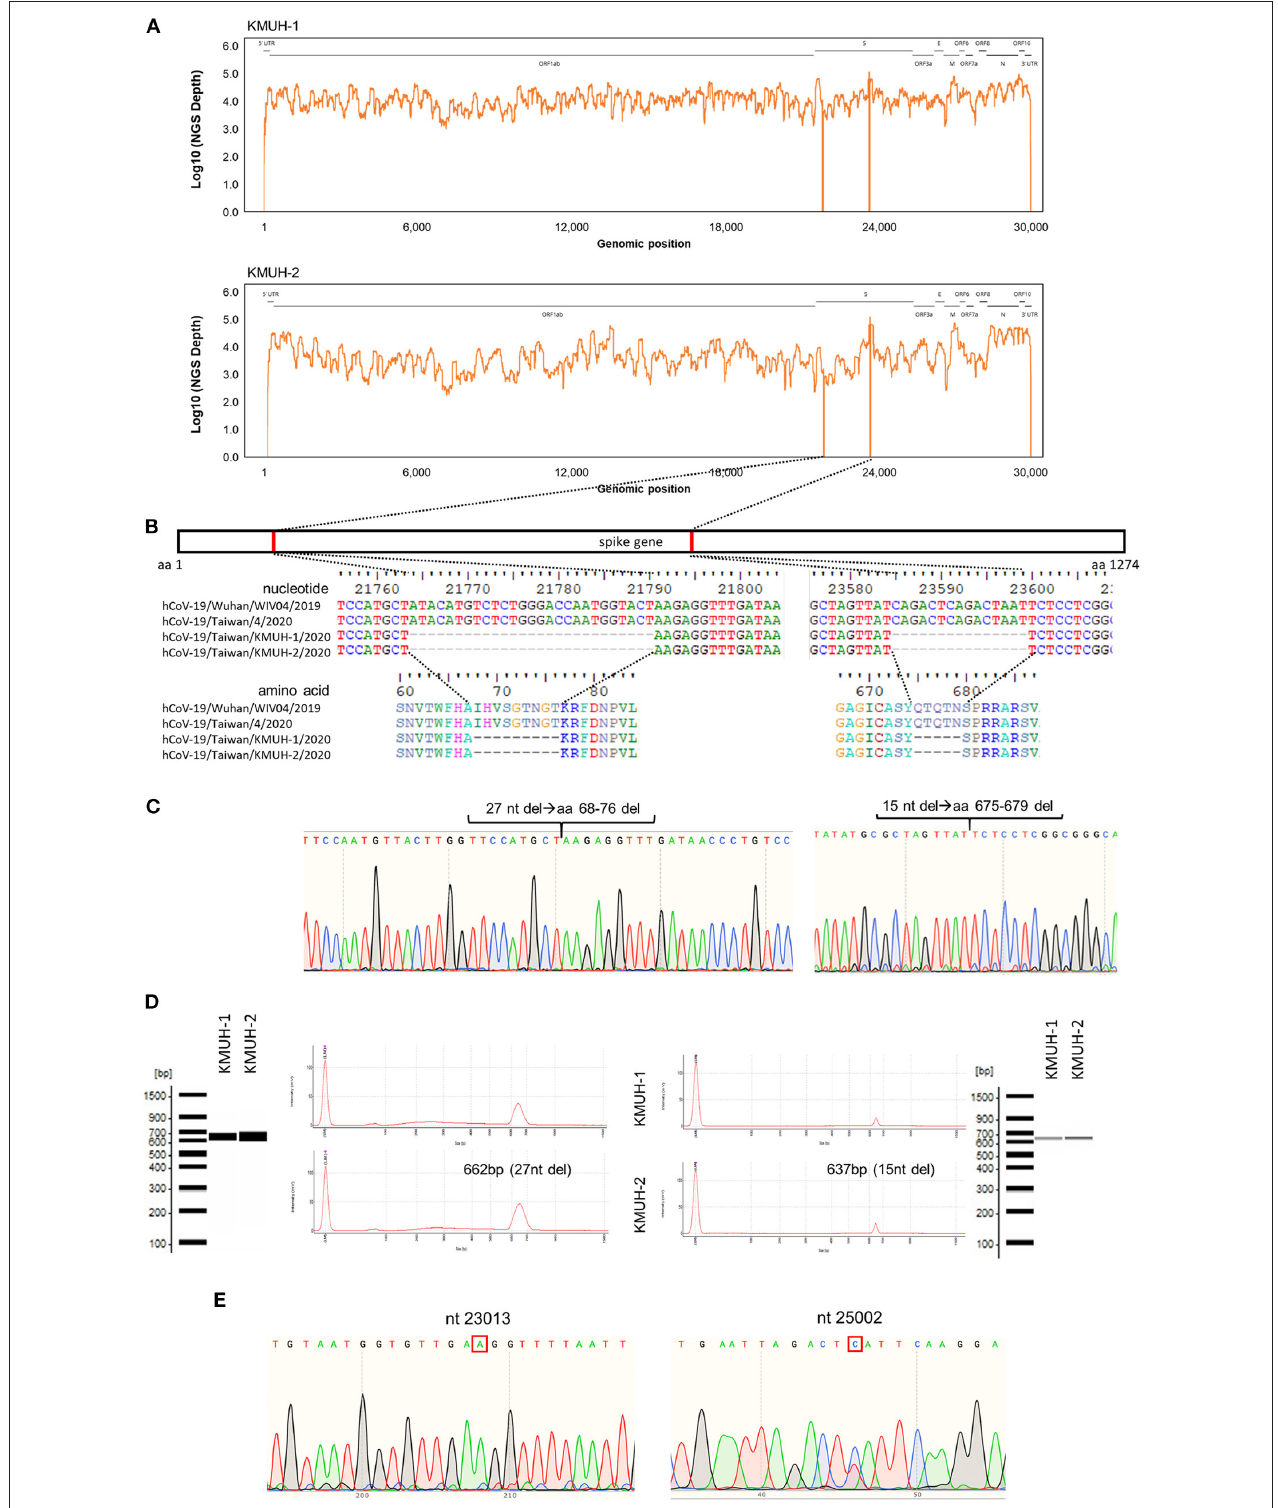
FIGURE 1 | In-frame deletion and SNV in the spike gene in the SARS-CoV-2 genome. (A) WGS coverage and depths of KMUH-1 and KMUH-2. (B) Genomic regions of the spike gene deletion according to the genomic positions of the reference strain Wuhan-Hu-1/2019. (C) Results of Sanger sequencing of the regions spanning deletions in the spike gene in KMUH-1 and KMUH-2. (D) Deletions in the spike gene were verified by RT–PCR, which showed a reduced amplicon size. (E) Sanger sequencing of nt positions 23,014 and 25,002, which resulted in E484D and S1147L aa substitutions in the spike protein. The Sanger sequencing results of KMUH-1 were used as a